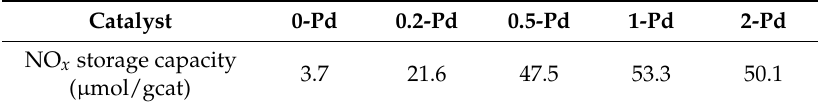
Figure 3. NO x adsorption profiles (Temperature: 80 °C; Flow: NO x , CO, H 2 O, O 2 , CO 2 , balanced with N 2 , 1 L/min). Table 2. NO x storage capacities in NO x , CO, H 2 O, O 2 and CO 2 .